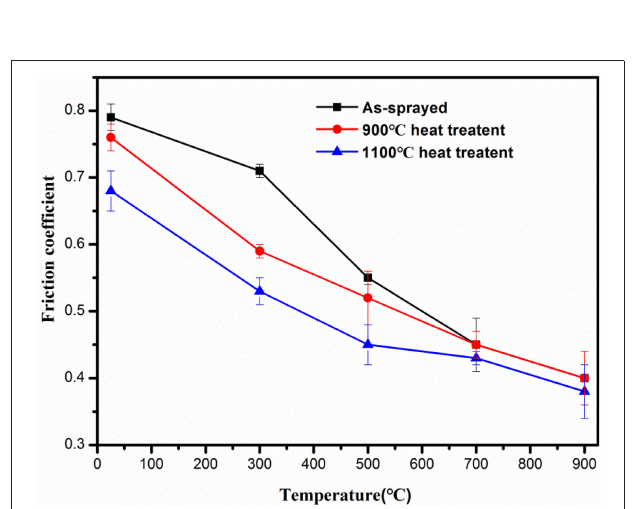
FIGURE 9 | The friction vs. rotating time curves of coating heat-treated at 1,100 ◦ C tested at different friction test temperatures.